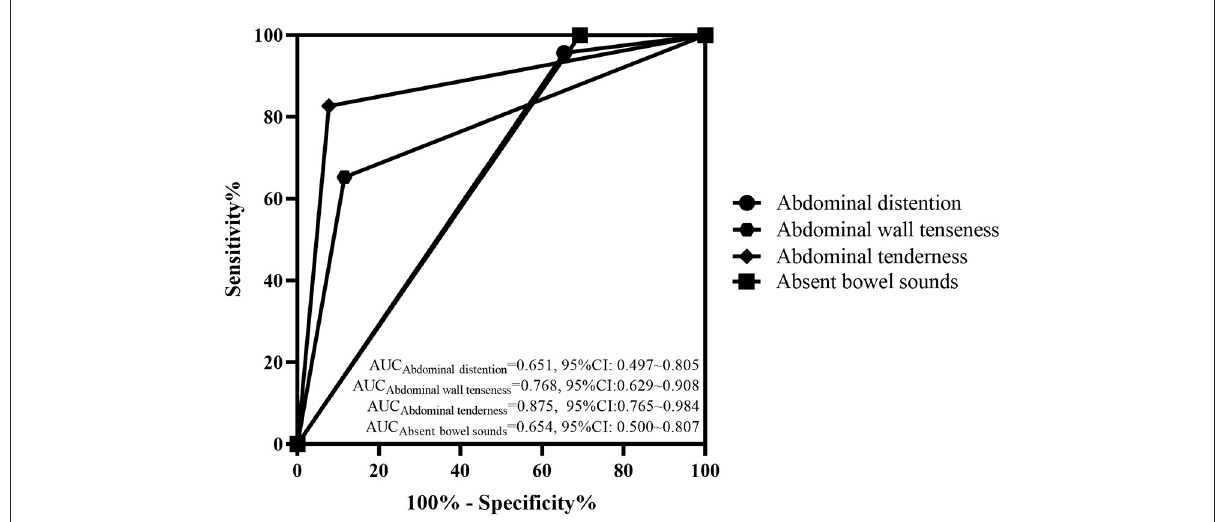
FIGURE1 ROC curve of the abdominal signs in the two groups. The AUCs of abdominal distention, abdominal wall tenseness, abdominal tenderness and absent bowel sounds were 0.651 (95% CI: 0.497–0.805), 0.768 (95% CI: 0.629–0.908), 0.875 (95% CI: 0.765–0.984), and 0.964 (95% CI: 0.500–0.807),